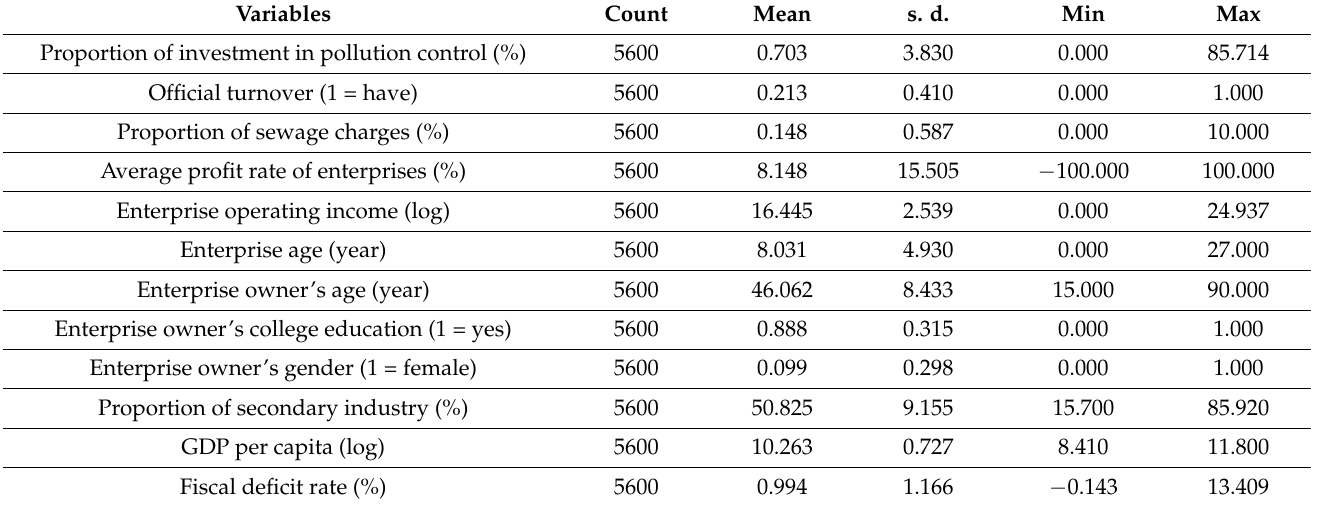
Table 1. Descriptive statistics of